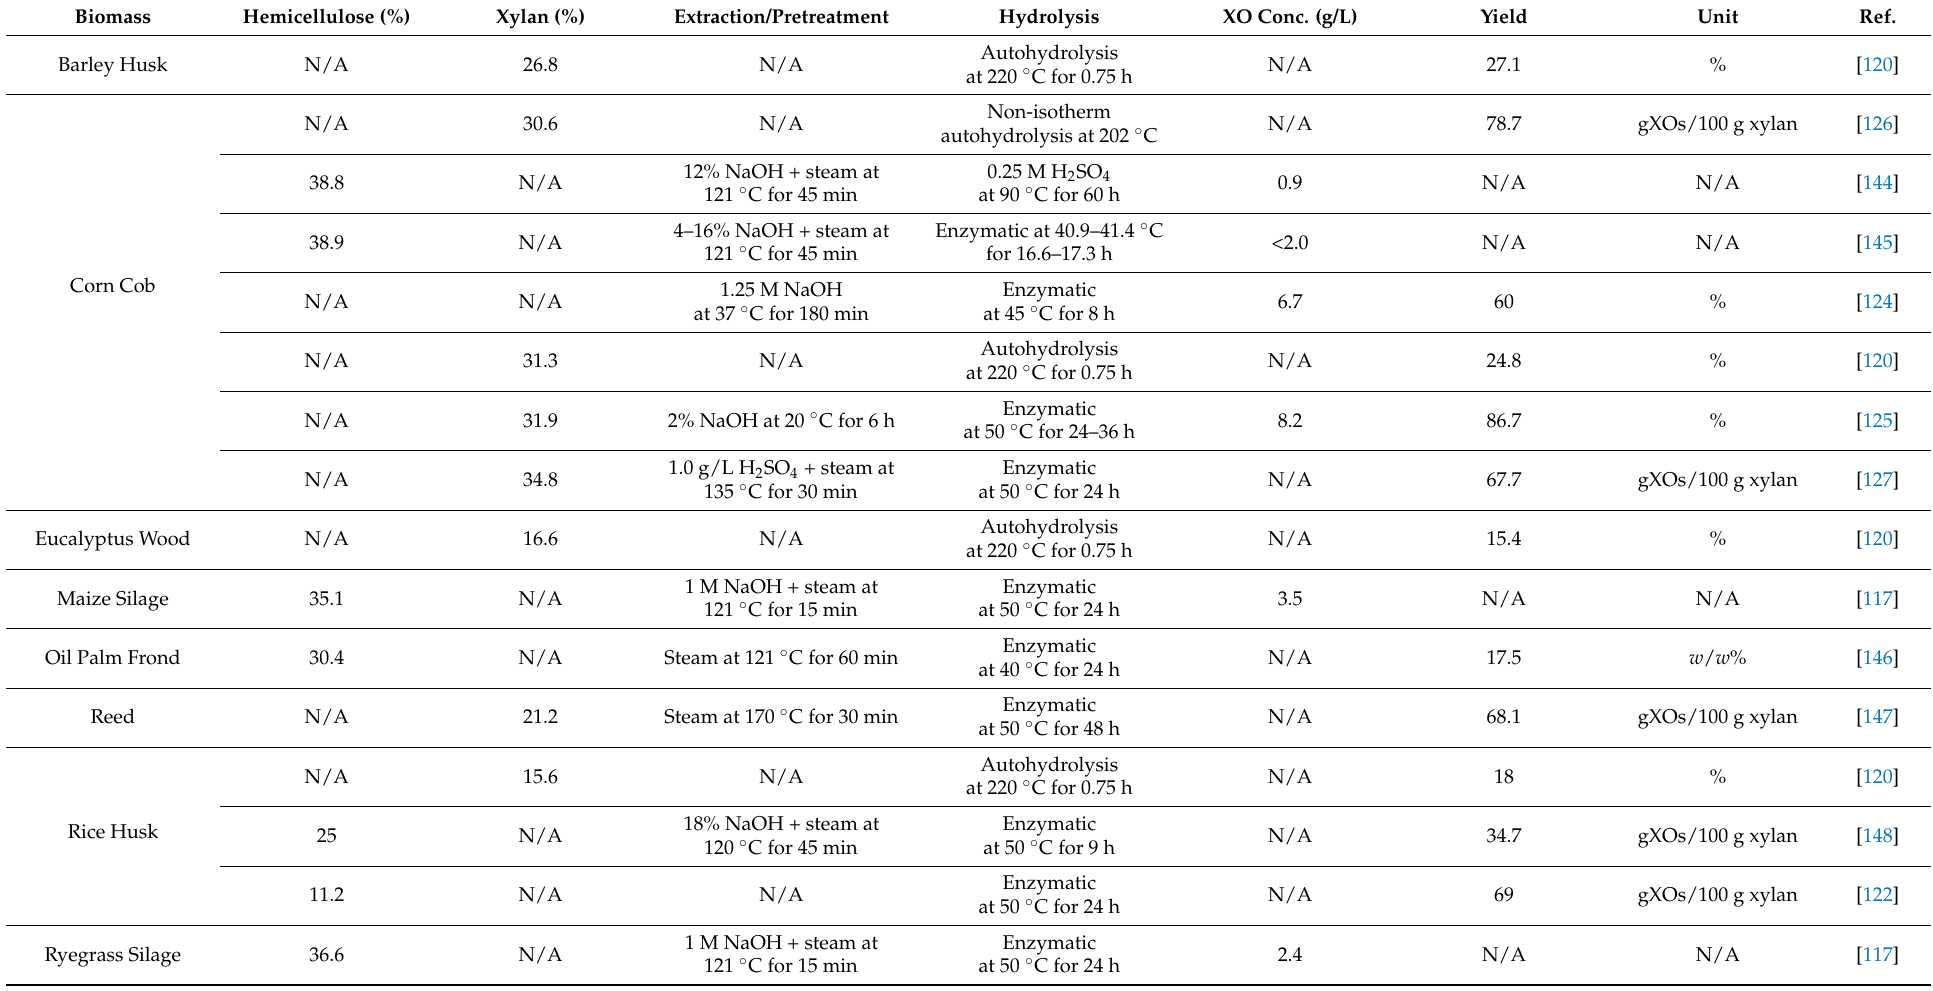
Table 9. Review of xylo-oligosaccharide (XO) production from